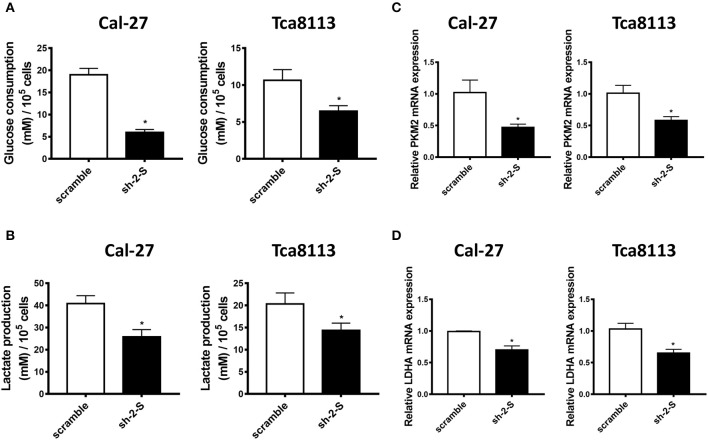
STAT3 knockdown inhibits aerobic glycolysis in OSCC cells. (A) Glucose consumption assay was used to detect the glucose consumption in STAT3-knockdown Cal-27 and Tca8113 cells. The data showed that down-regulation of STAT3 led to lower glucose consumption in Cal-27 and Tca8113 cells. (B) Lactate production assay was used to detect the lactate production in STAT3-knockdown Cal-27 and Tca8113 cells. The data showed that down-regulation of STAT3 led to lower lactate production in Cal-27 and Tca8113 cells. (C) PKM2 mRNA levels in STAT3-knockdown Cal-27 and Tca8113 cells were examined by qRT-PCR. (D) LDHA mRNA levels in STAT3-knockdown Cal-27 and Tca8113 cells were examined by qRT-PCR. Each assay was carried out in triplicate. Results were shown as means ± SD. *P < 0.05.